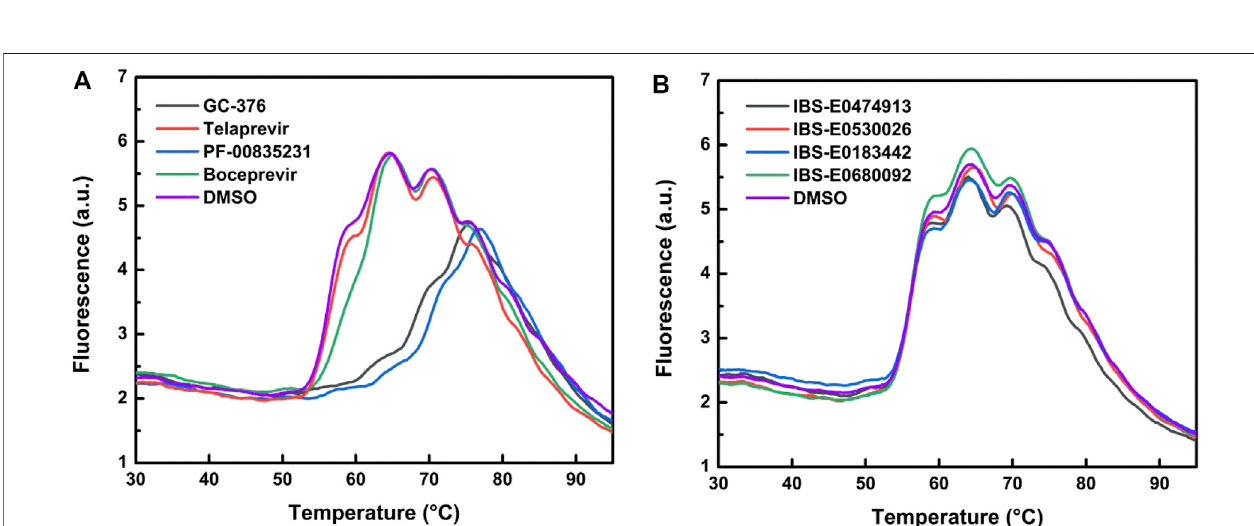
Frontiers in Pharmacology |